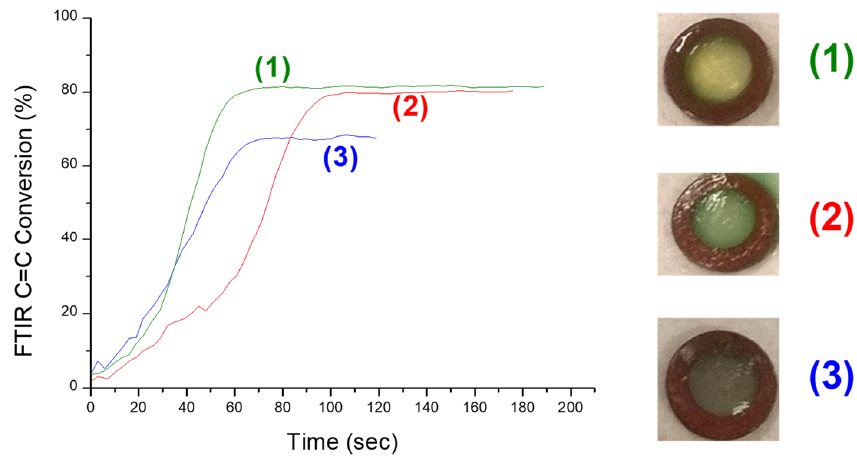
Figure 37. Polymerization profiles obtained during the FRP of the (1,4-BDMA / HPMA / UDMA) blend under air with the two-component Cu-42 / 2-dppba (1% / 1.5% w / w ) systems with Cu-42 prepared (1) by mechanosynthesis (2) in solution (3) starting from Cu(acac) 2 and 2-dppba. Inset: pictures of the polymer films after polymerization. Reproduced with permission from the authors of [69]. Copyright 2017 John Wiley & Sons Ltd.